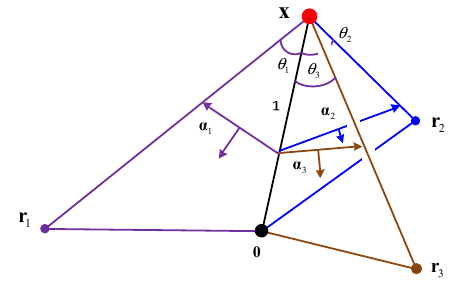
Figure 4. Geometry of α i .